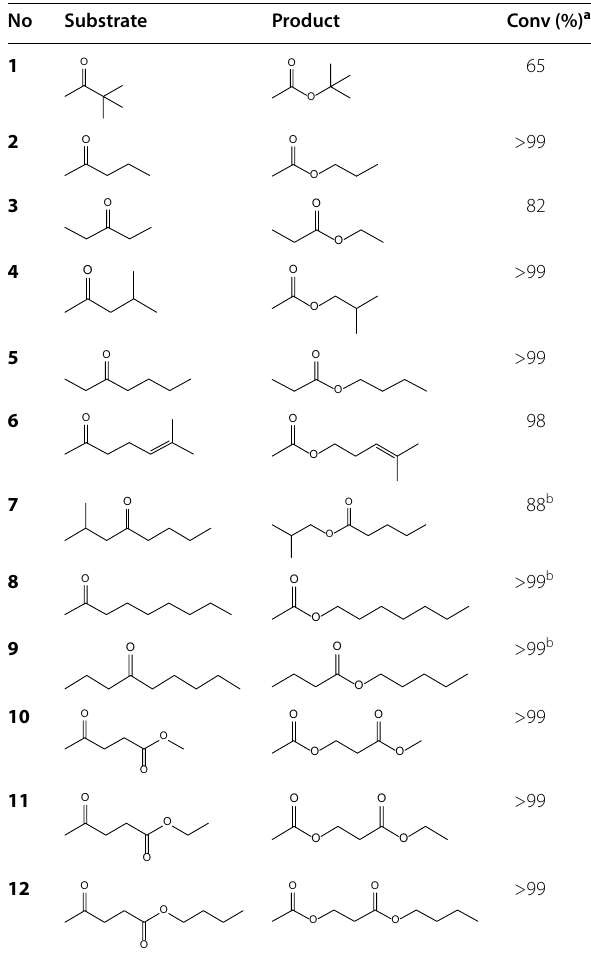
Table 1 Biotransformations of linear- and branched-chain ketones mediated by BVMO Lepto